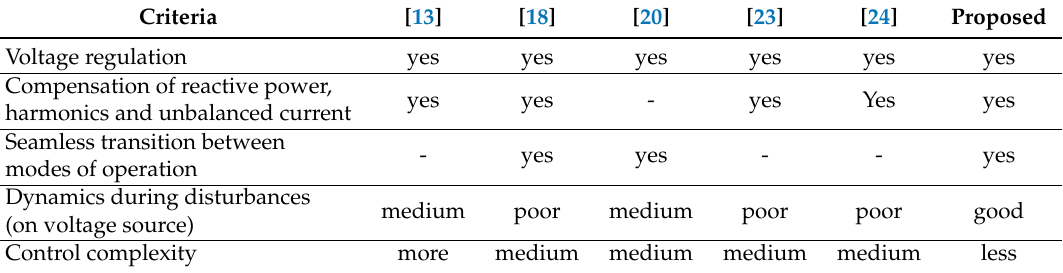
Figure 13. Transition of microgrid during islanded to grid connected operation mode. Table 2. Comparative analysis of proposed control